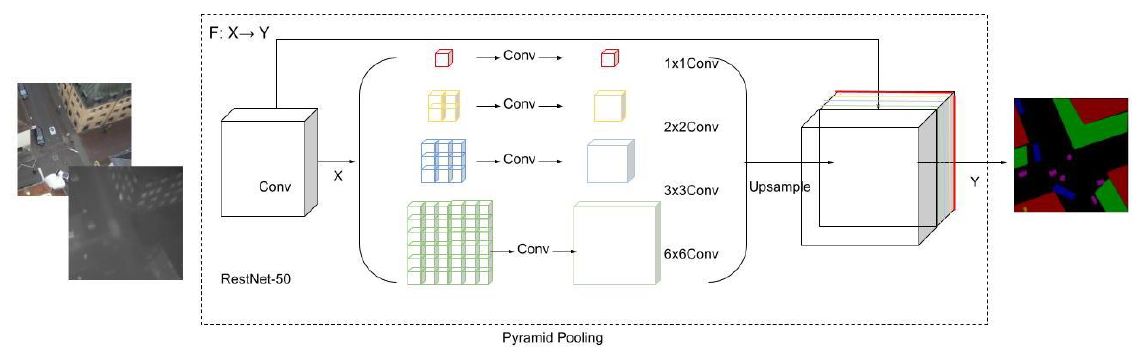
Figure 2. Illustration of the fusion approach on PSPNet.